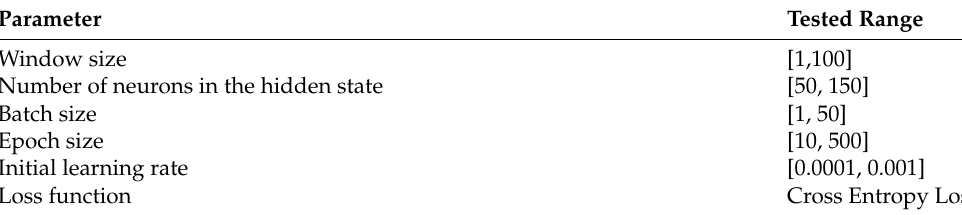
Table 3. Range and hyperparameters tested by the genetic